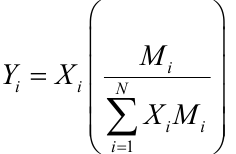
Table 1. Values of σ